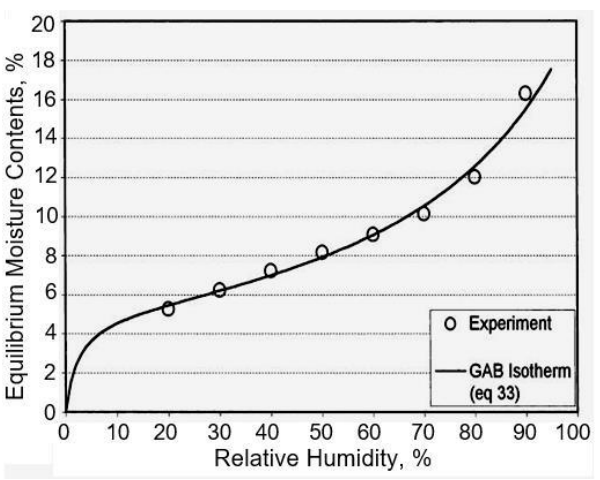
Figure 6. Sorption isotherm of bleached kraft paperboard (BKP) at 23.9 °C and atmospheric pressure. Reprinted with permission from [224]. Copyright 2003: ACS.